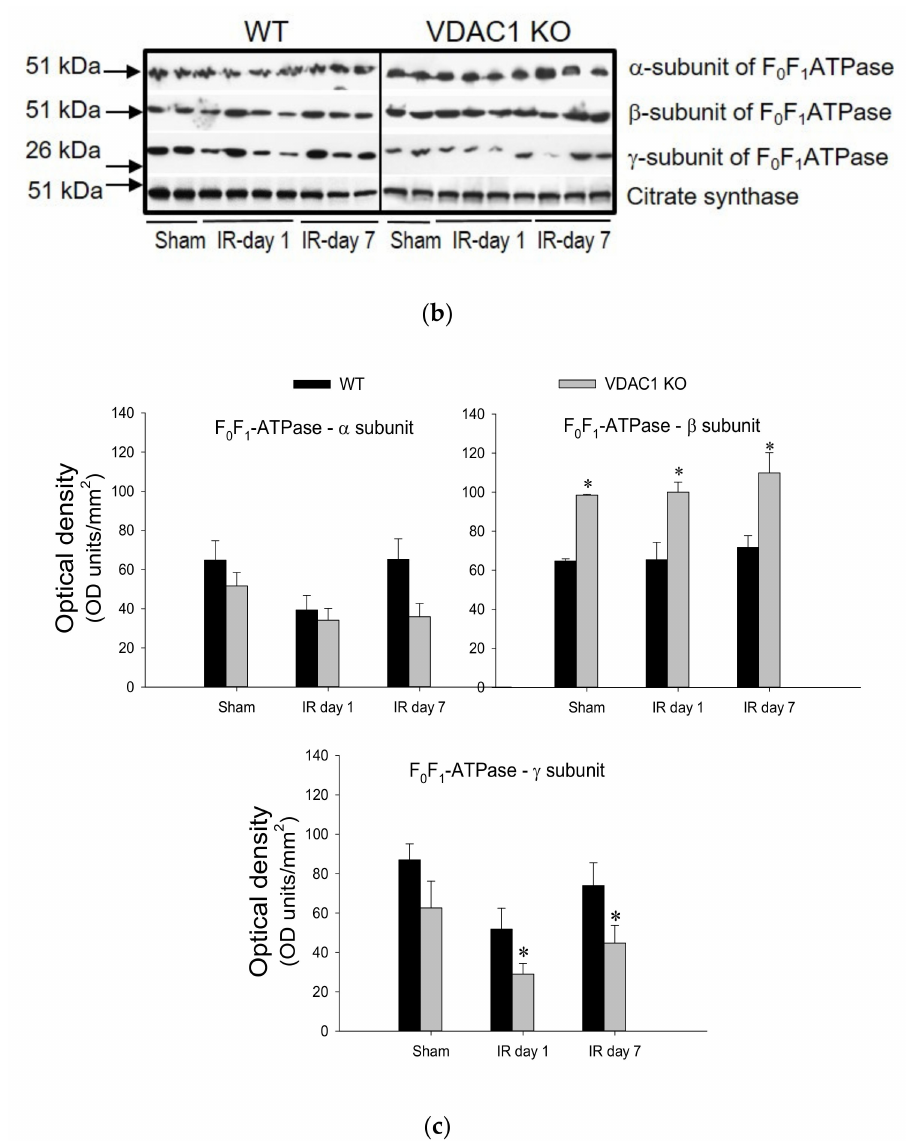
Figure 8. Deletion of VDAC1 blocks recovery of F 0 F 1 -ATPase activity in the renal cortex after ischemia-induced acute kidney injury (AKI). ( a ) Activity of F 0 F 1 -ATPase in mitochondria isolated from renal cortices of wild type (WT) and VDAC1-deficient (VDAC1 KO) mice on days 1 and 7 after bilateral renal ischemia (35 min). Results are the average ± S.E. of data obtained from 4–7 animals. * Values significantly di ff erent ( p < 0.05) from respective WT sham-operated mice. # Values significantly di ff erent ( p < 0.05) from respective VDAC1 KO sham-operated mice. ( b ) Protein levels of subunits α , β , and γ of the F 1 (catalytic) domain of F 0 F 1 -ATPase during recovery after bilateral renal ischemia (35 min) in WT and VDAC1 KO mice. The blots show representative results from renal cortical mitochondria in three sham-operated mice, four mice sacrificed on day 1, and three mice sacrificed on day 7 post reperfusion in di ff erent experiments. ( c ) Densitometric analysis of immunoblots shown in ( b ). * Values significantly di ff erent ( p < 0.05) from respective WT